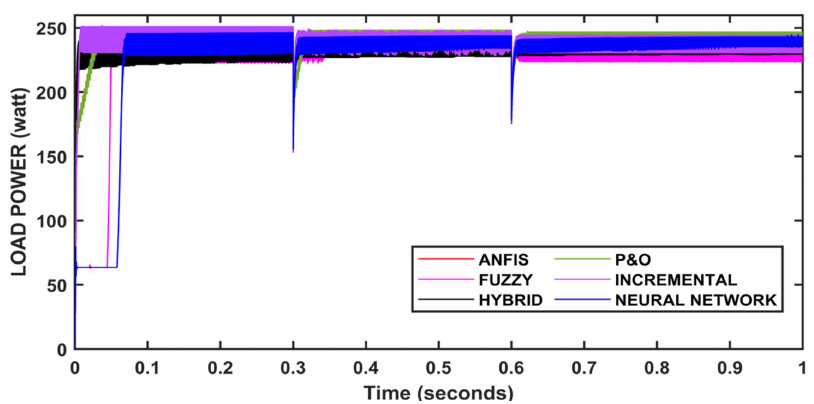
Figure 45. Controller performance at constant irradiation and varying loads.